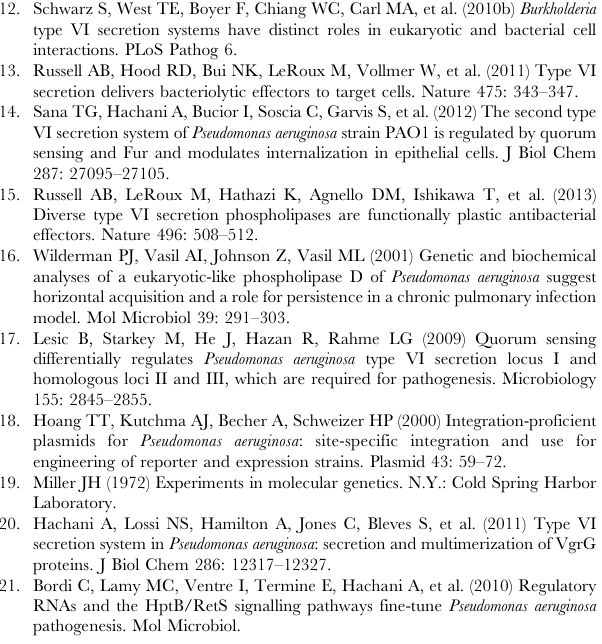
Figure S1 H2-T6SS and H3-T6SS are differentially thermoregulated. The expression pattern of the H2-T6SS-lacZ (A), H3-T6SS left-lacZ (B), and H3-T6SS right-lacZ (C) transcrip- tional fusions in the WT PAO1 strain is given in Miller Units at different time points over the growth and at 3 different temperatures: 30 u C (blue), 37 u C (green) and 42 u C (red). The OD 600 is also presented (diamonds). A control strain (PAO1Z) (grey squares) is included for each graph. Each experiment was done in triplicate and independently repeated three times; error bars indicate the standard deviation. (TIF) Figure S2. Sfa2 and Sfa3 are EBPs. Sfa2 (A) and Sfa3 (B) are 503 and 361 amino acids long. Both proteins possess WalkerA, Switch ASN, GAFTGA, WalkerB and Arg Fingers motifs that are specific to s 54 activators. (TIF) Figure S3 Sfa3 has no effect on QS gene expression. Expression of rhlR-lacZ (A) and lasR-lacZ (B) transcriptional fusions is given in Miller Units after 4 h of growth in the PAO1 strain overproducing Sfa2 (red bars) or not (blue bars, empty vector). Each experiment was done in triplicate and independently repeated three times; error bars indicate the standard deviation.